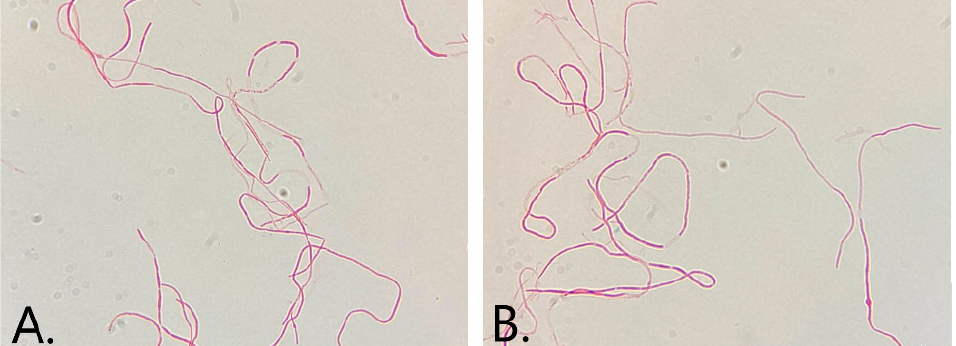
Figure 3. ( A , B ) Gram stain of the pure isolated bacterial colonies presenting long filamentous Gram-negative rods ( × 1000).